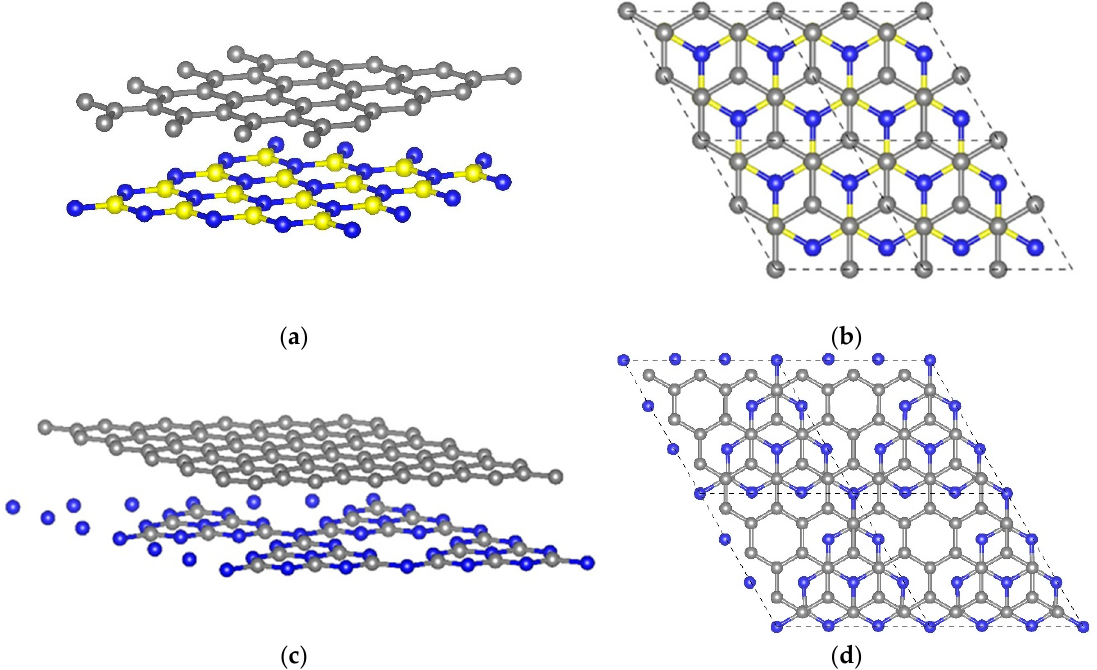
Figure 1. The atomic structures of hexagonal graphene supercells: graphene deposited on the hexagonal boron nitride (perspective view ( a ), top view ( b )) and graphitic carbon nitride (perspective view ( c ), top view ( d )). Gray, blue, and yellow balls represent C, N, and B atoms, respectively.